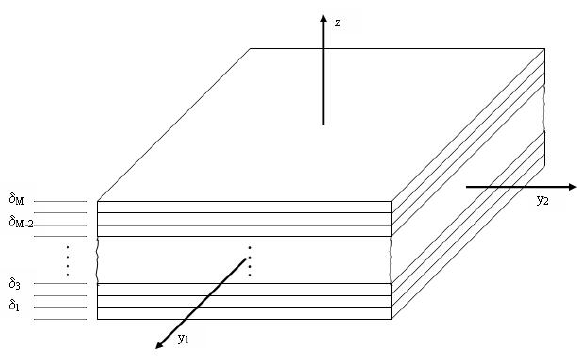
Figure 2: Laminated magnetoelectric composite